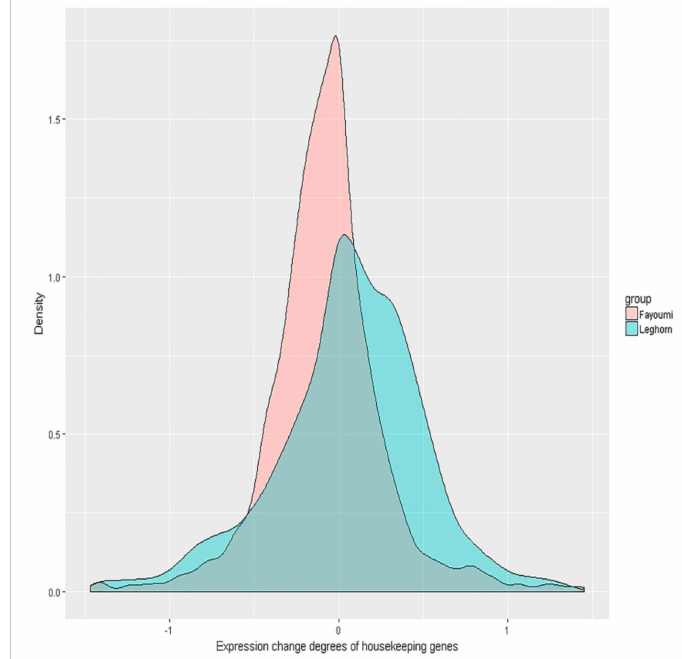
Figure 3. Housekeeping gene expression di ff erence distribution in Fayoumi and Leghorn chickens. The x-axis represents the housekeeping gene expression di ff erence for the two breeds. The values were calculated as log 2 (gene expression levels of Fayoumi individuals with AIV inoculation / gene expression levels of Fayoumi individuals challenged with PBS) or log 2 (gene expression levels of Leghorn individuals with AIV inoculation / gene expression levels of Leghorn individuals challenged with PBS). The y-axis represents the density of the gene expression di ff erence